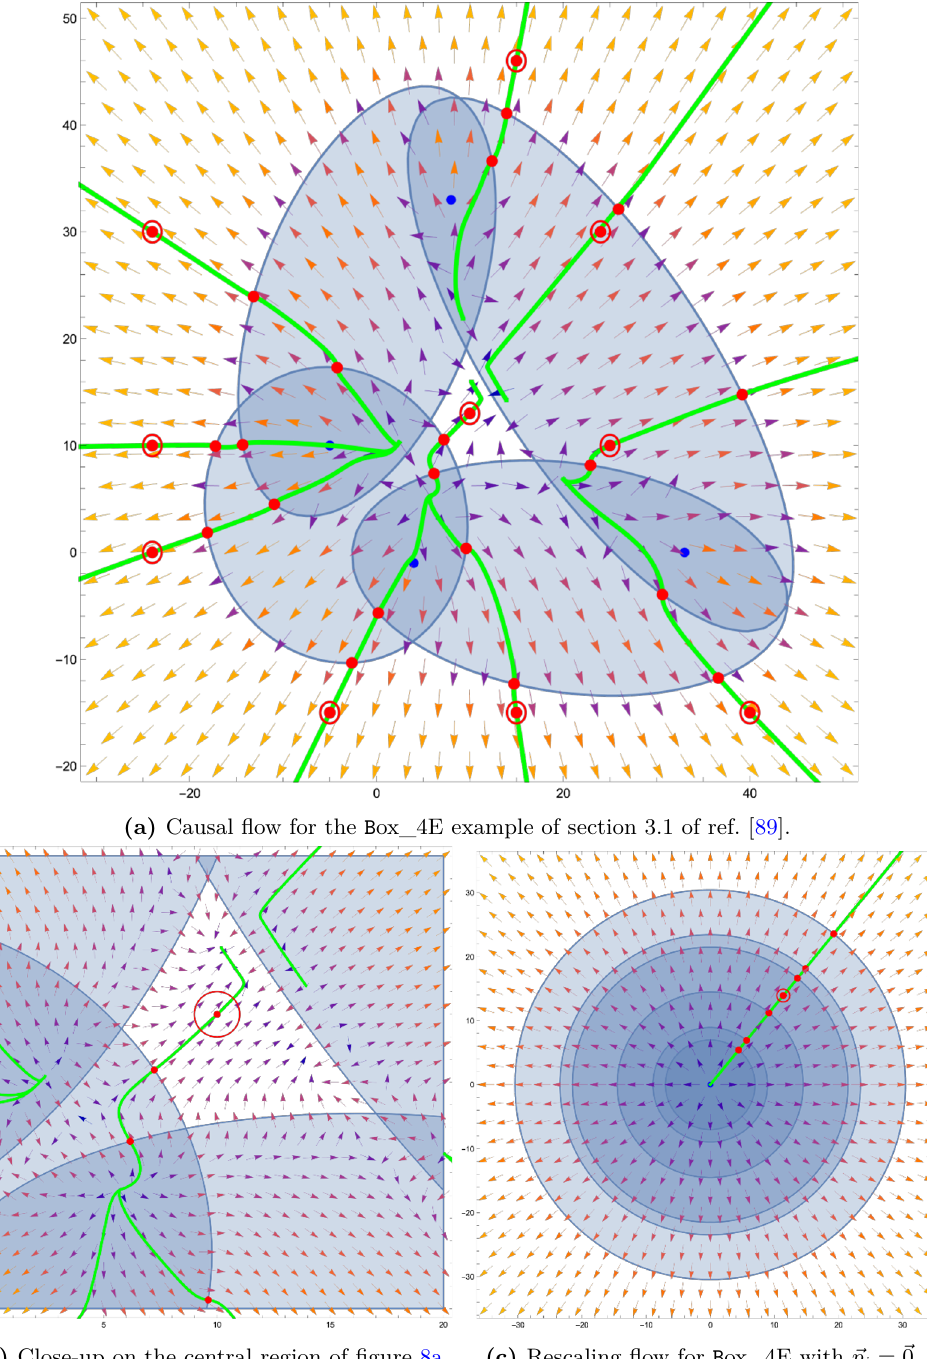
Figure 8. Causal flow for the complicated maximal overlap structure of the B ox_4E one-loop example of section 3.1 of ref. [89] (figures 8a and 8b) and its much simpler pure rescaling counterpart when setting all spatial parts of the external momenta of B ox_4E to zero (figure 8c). The x and y axes indicate the k and k component of the B ox_4E loop momentum. The circled red point x y indicates possible input sampling points that the LU representation depends on and the non-circled red points depict the various projections induced by the causal flow on the contributing E-surfaces. The green lines represent ~φ − 1 [ V ] with V being the circled dots. The vector field depicts the orientation of the contour deformation vector constructed according to ref. [89] (using the four deformation sources indicated with blue dots), and its colour pertains to its relative